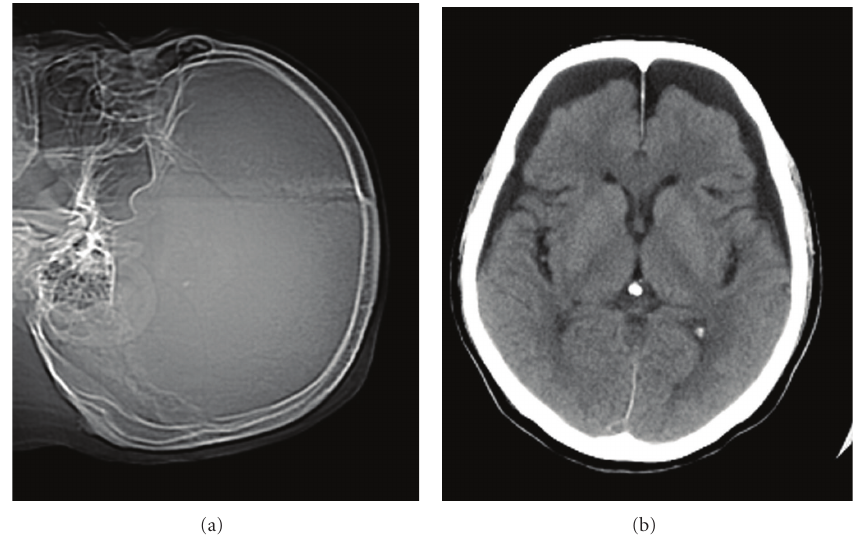
Figure 3: One month postoperative head image ((a): Plain radiograph, (b): CT). (a) Plain radiograph demonstrates the disappearance of intracranial air. (b) CT one month after surgery demonstrates the disappearance of air in the overall space. (c) CT: Computed